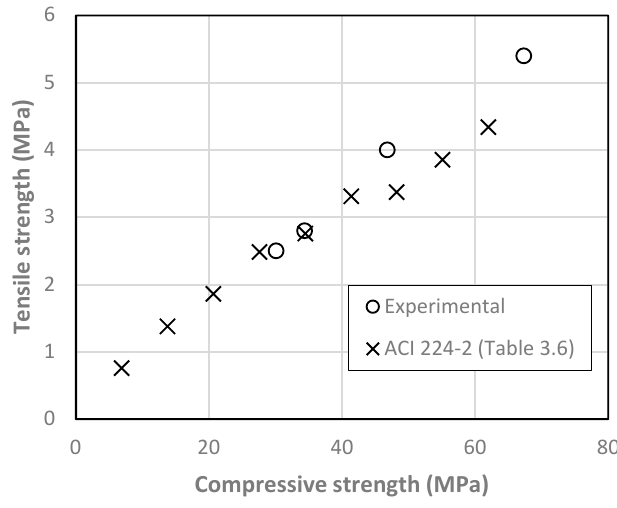
Figure 7. Relationship between matrix compressive and tensile strength.